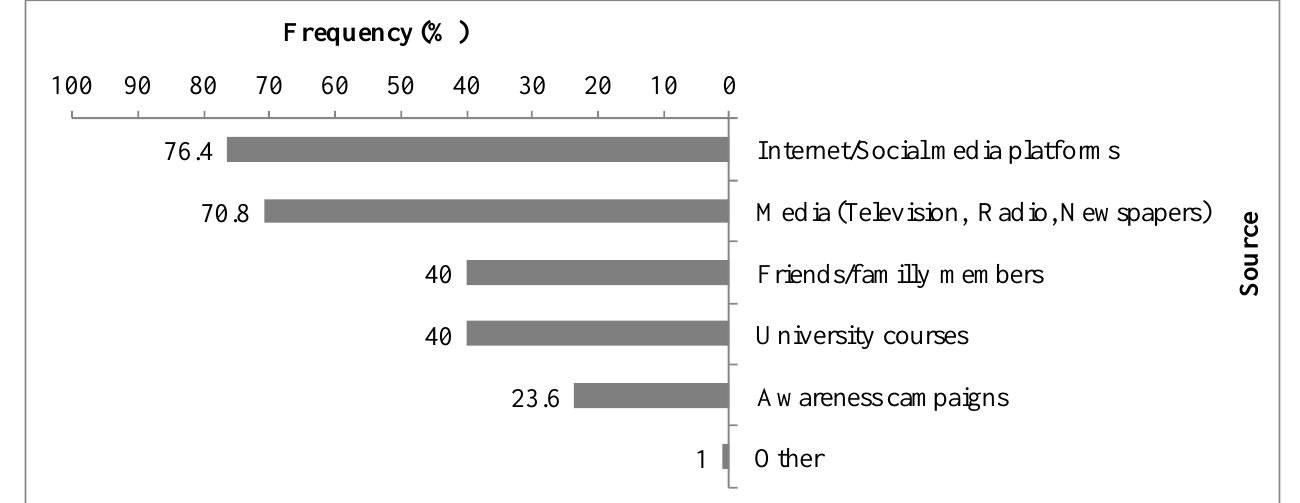
Table 3. Score of knowledge about CC of the study